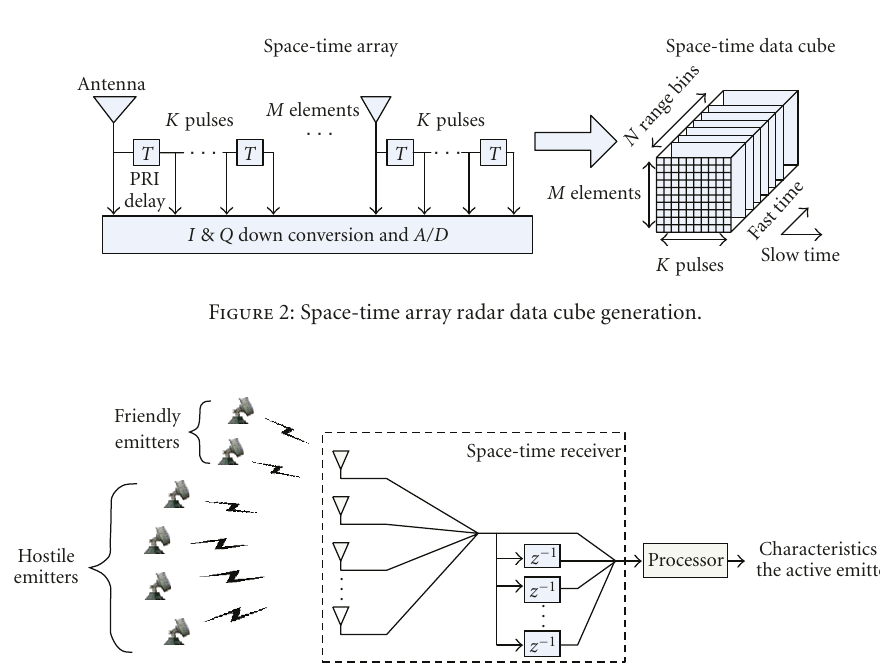
Figure 3: Space-time receiver architecture of the advanced ESM